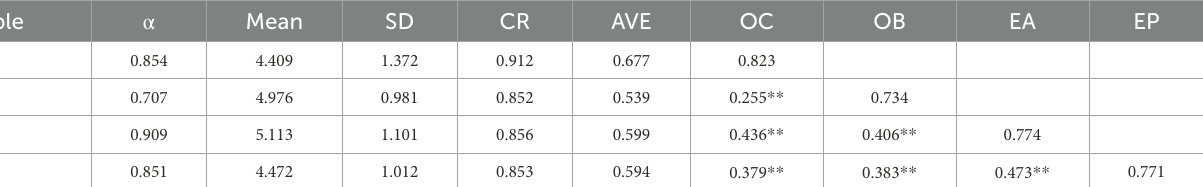
TABLE 3 Results of the reliability and validity analysis.